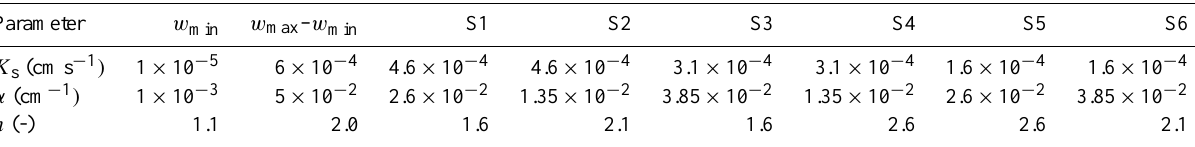
ing OD = 1 cm, parameter n converges to two main values: one approximately 2.5 and the other one approximately 1.7 (Fig. 2a). For OD = 2 cm and OD = 12 cm, the convergence ues. For OD = 2 cm, n converges to a value approximately